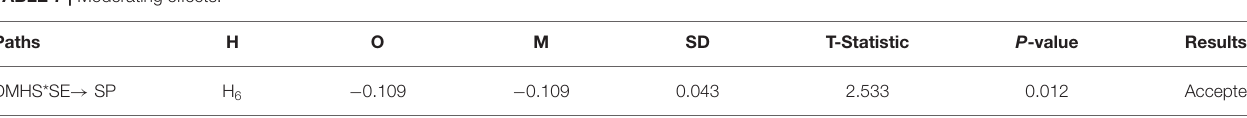
TABLE 7 | Moderating